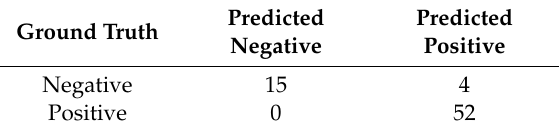
Table 4. Confusion matrix for the training set.